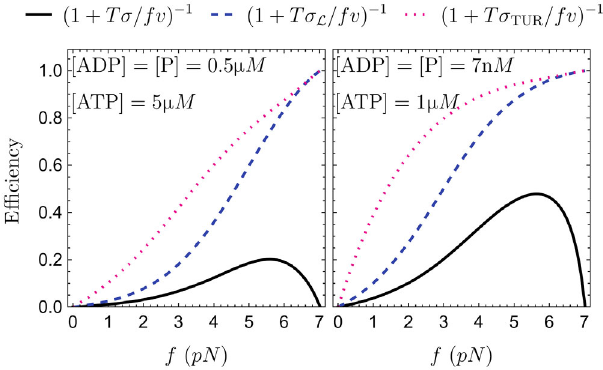
FIG. 13. Efficiency (solid black line) of a kinesin motor doing work against a force f , and its upper bounds obtained from the visible entropy production (dashed blue line) and the thermo- dynamic uncertainty relation (dotted magenta line). More details are given in Sec. VI